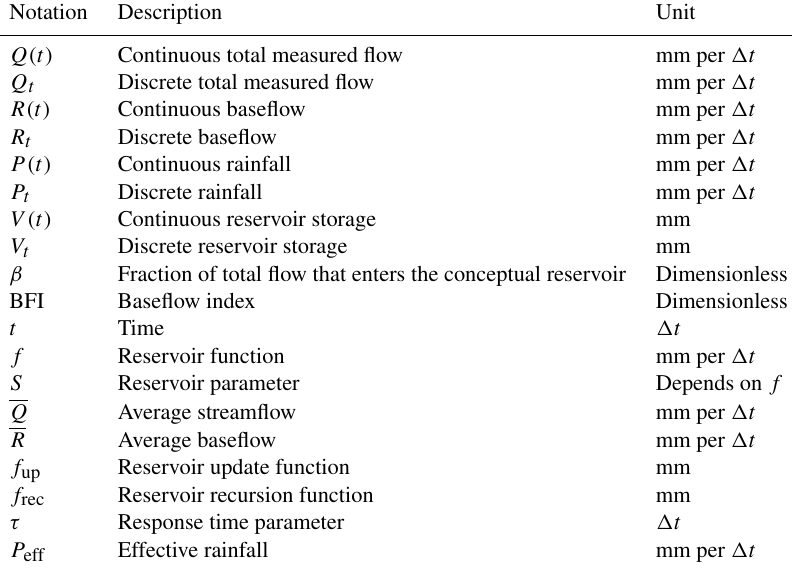
Table 1. List of